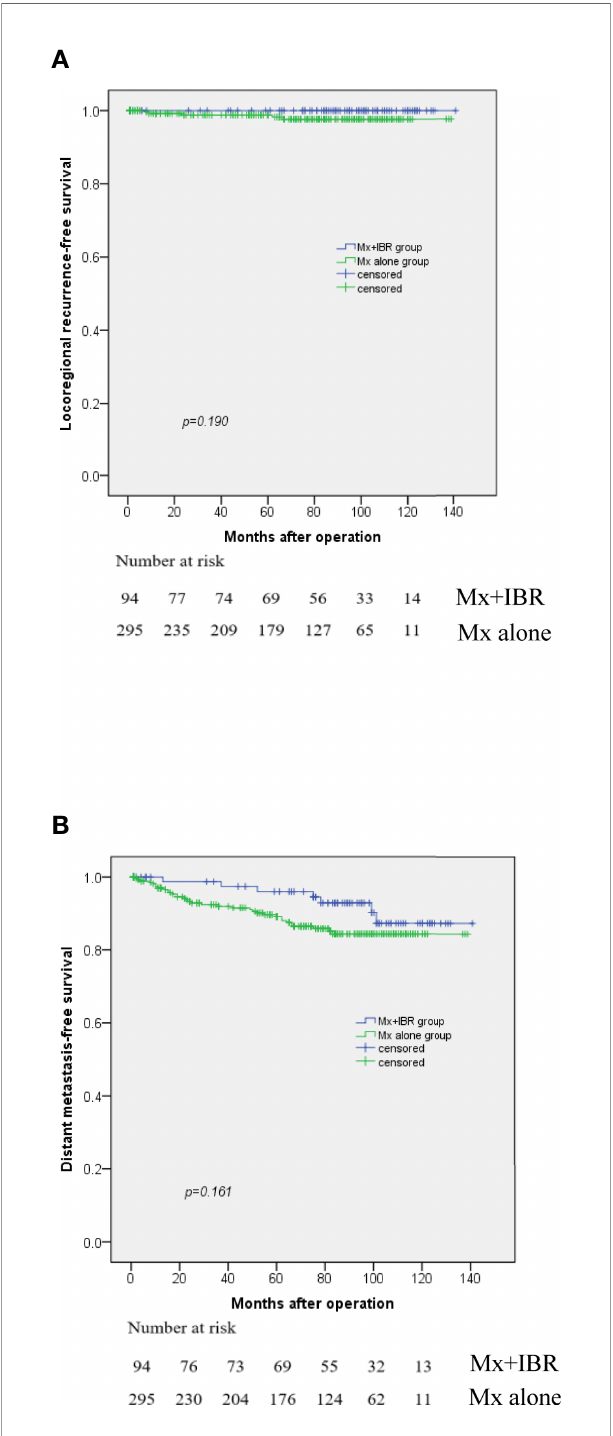
FIGURE 1 | Kaplan – Meier curve for locoregional recurrence (A) and distant metastasis (B) among patients with or without immediate breast